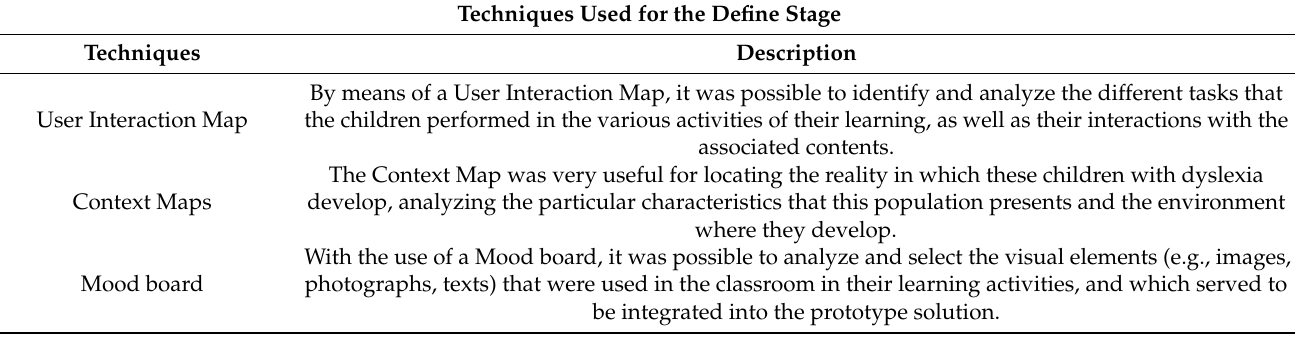
Table 5. Description of techniques used in the Devise stage.